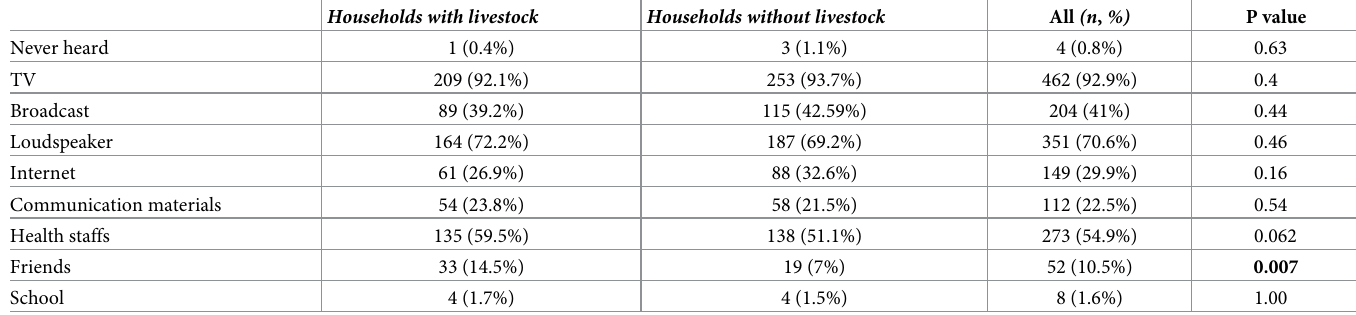
Table 5. Reported sources of information about MBDs in households with and without livestock in Hanoi, Vietnam. Households with